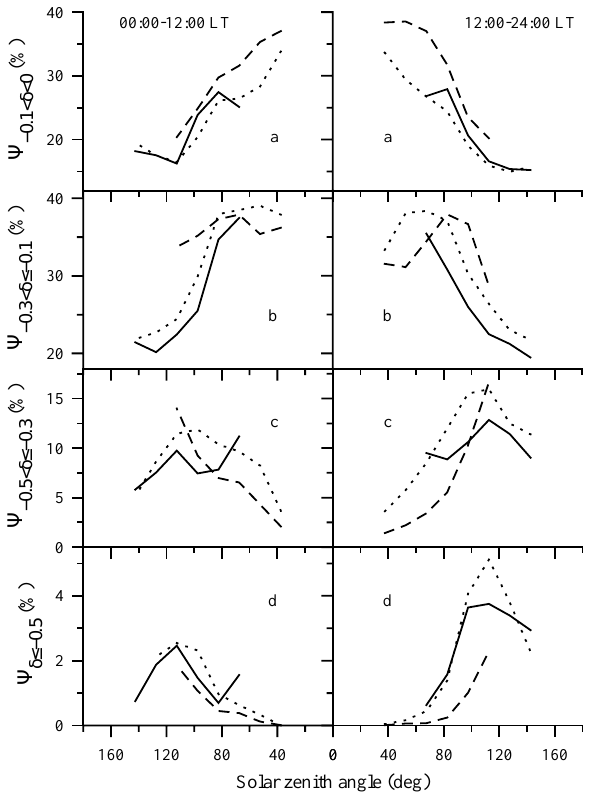
Fig. 10. The dependence of the Nm F2 negative disturbance proba- bility functions on the solar zenith angle in latitude range 5 (60 ◦ < | 8 | ≤ 90 ◦ ) during the winter (solid lines), summer (dashed lines), and spring and autumn (dotted lines) months for the weak (panels a), normal (panels b), strong (panels c), and very strong (panels d) Nm F2 negative disturbances. The 0 ◦ − 180 ◦ solar zenith angle range includes the local time period from 00:00LT to 12:00LT (left panels) and from 12:00LT to 24:00LT (right